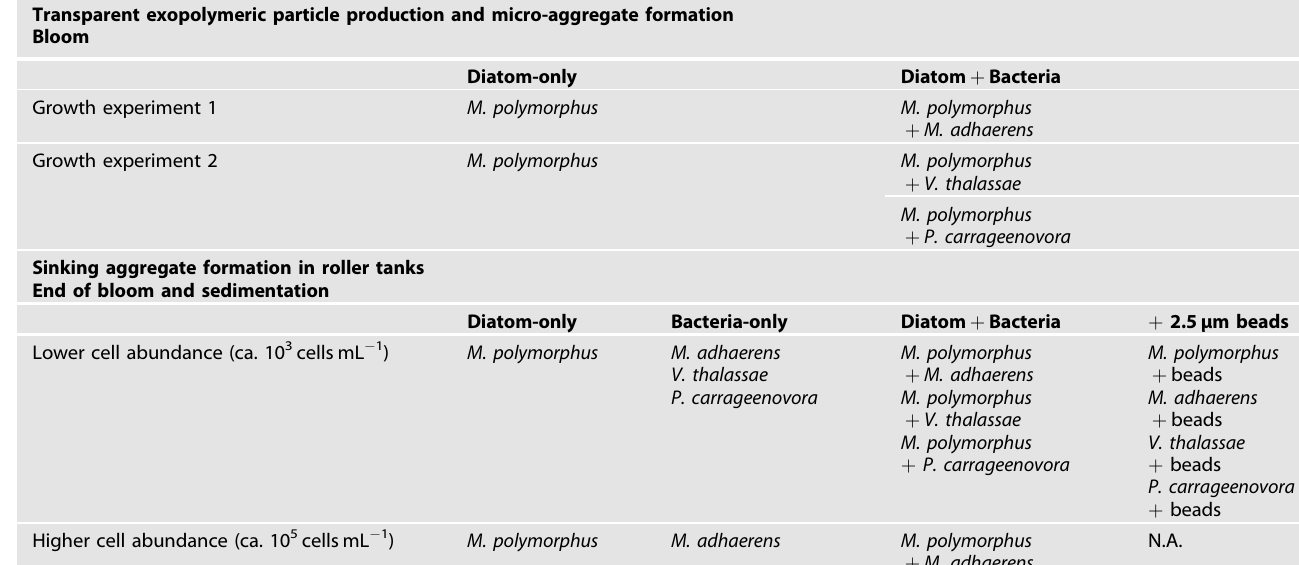
Table 1. Outline of the experiments performed in this